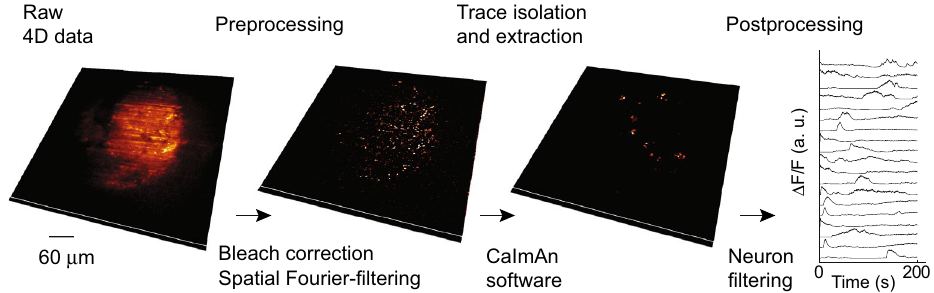
Figure 4. Processing pipeline to extract neuronal signals. To remove the fluorescent background in a first step, the sample is bleach-corrected and spatially filtered via a Fourier filter. Neuronal traces are extracted in 3D using CaImAn 44 . In a final step, neurons are filtered by volume and the temporal traces are filtered according to their variance (see “ Methods”